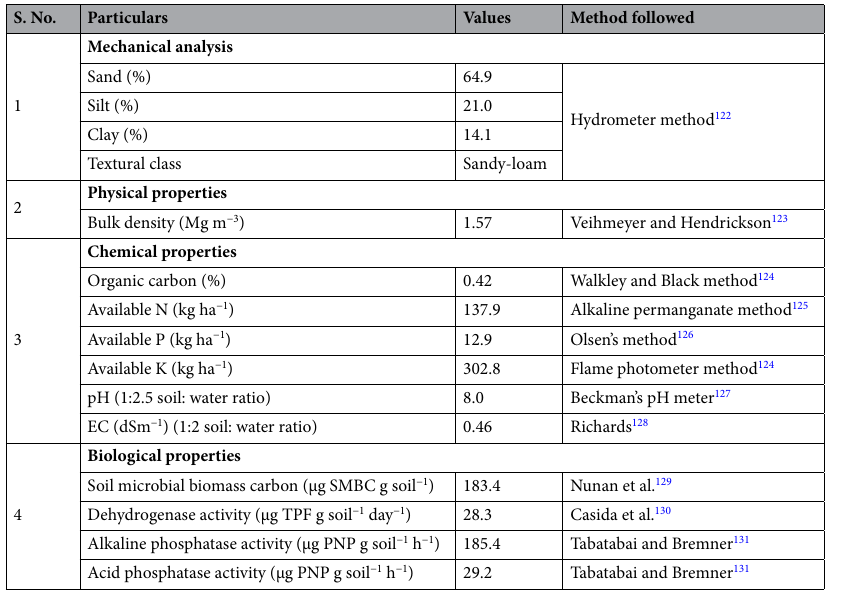
Table 4. Initial fertility status of the experimental